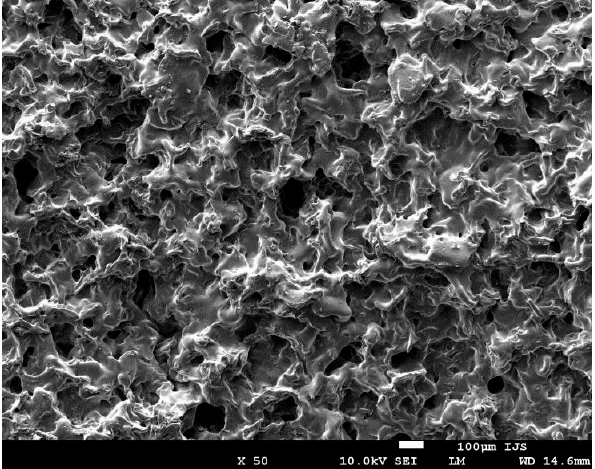
Figure 2. SEM image of an untreated PURPEG sample.